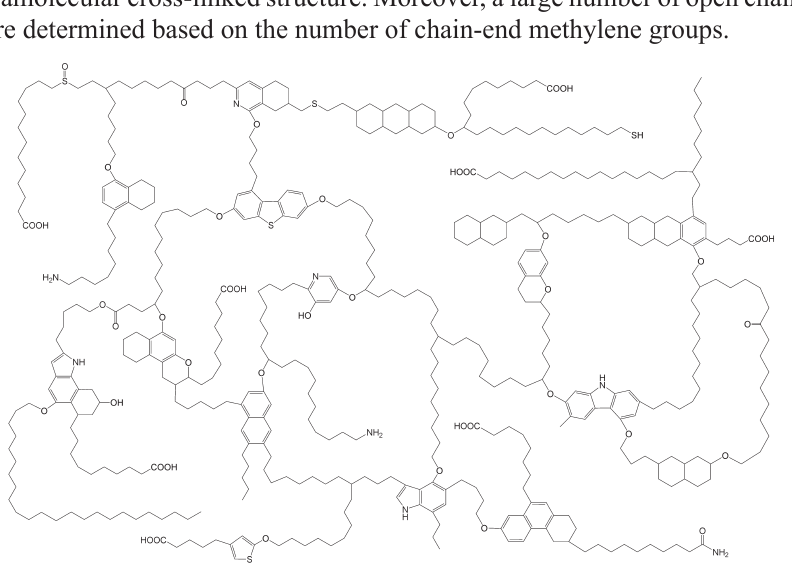
Fig. 2. 2D molecular model of Dachengzi oil shale kerogen. The chemical formula is C H O N S 487 778 43 8 5